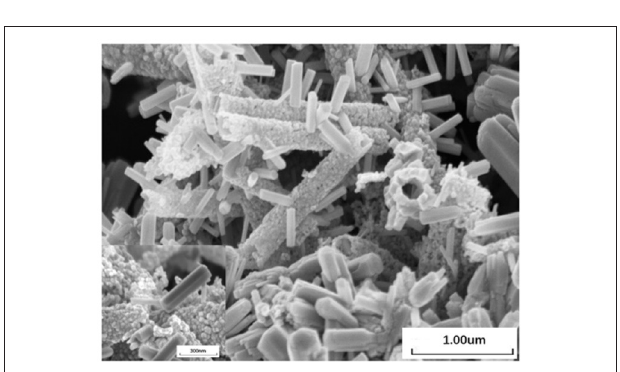
FIGURE 2 | SEM images of the SnO 2 /ZnO composite heterojunction.